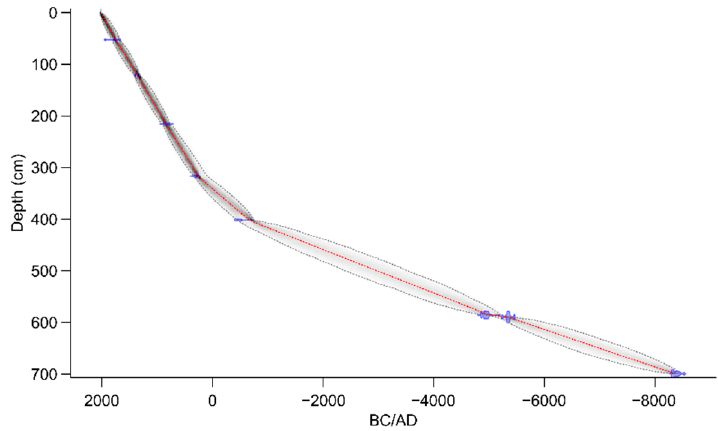
Figure 2. Age-depth model of the deposits of the Krivetskiy Mokh mire (KM, the calibrated 14 C dates are shown in blue, darker grey indicates more likely calendar ages, grey stippled lines show 95% confidence intervals, red curve shows single “best” model based on the mean age for each depth).